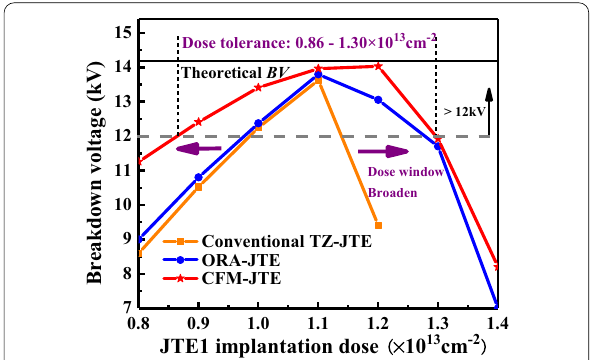
Fig. 2 Comparison of breakdown capacities to the JTE dose window for the 4H‑SiC PiN rectifier with CFM‑JTE, ORA‑JTE and conventional